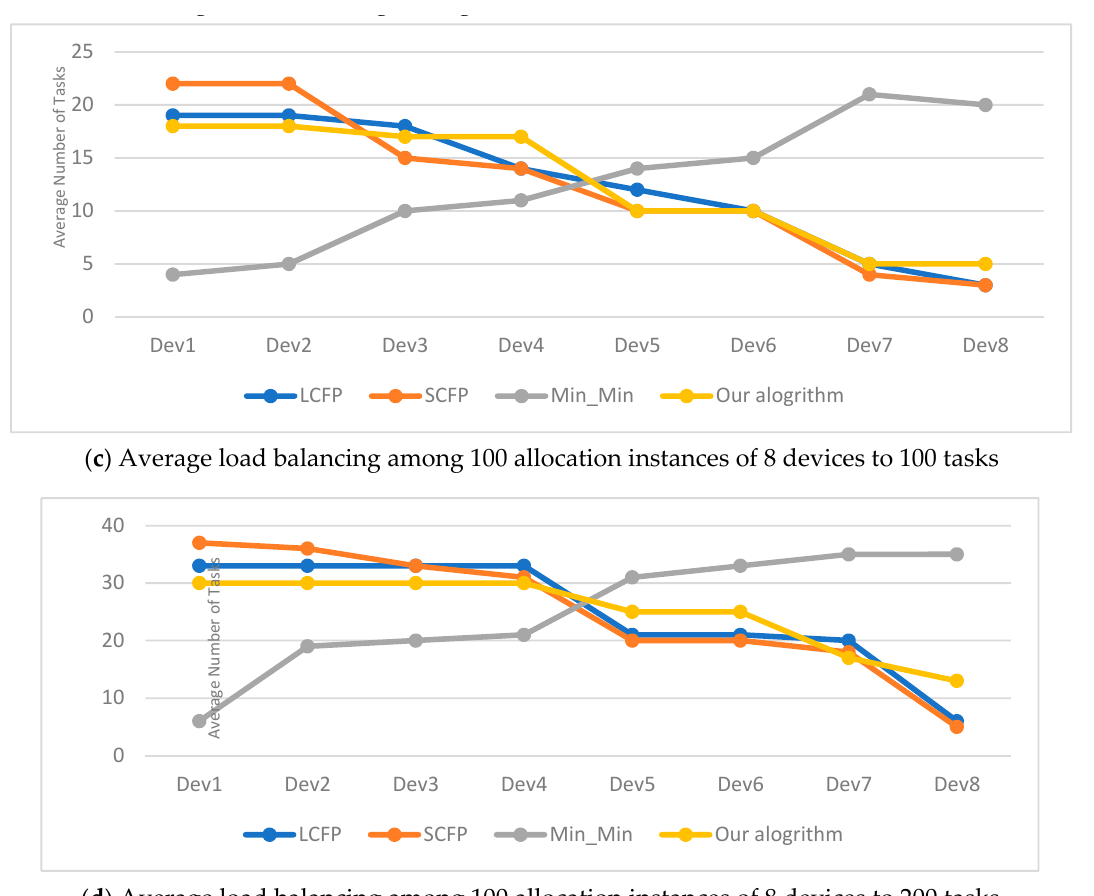
Figure 7. Experimental results for load balancing with respect to the four algorithms.